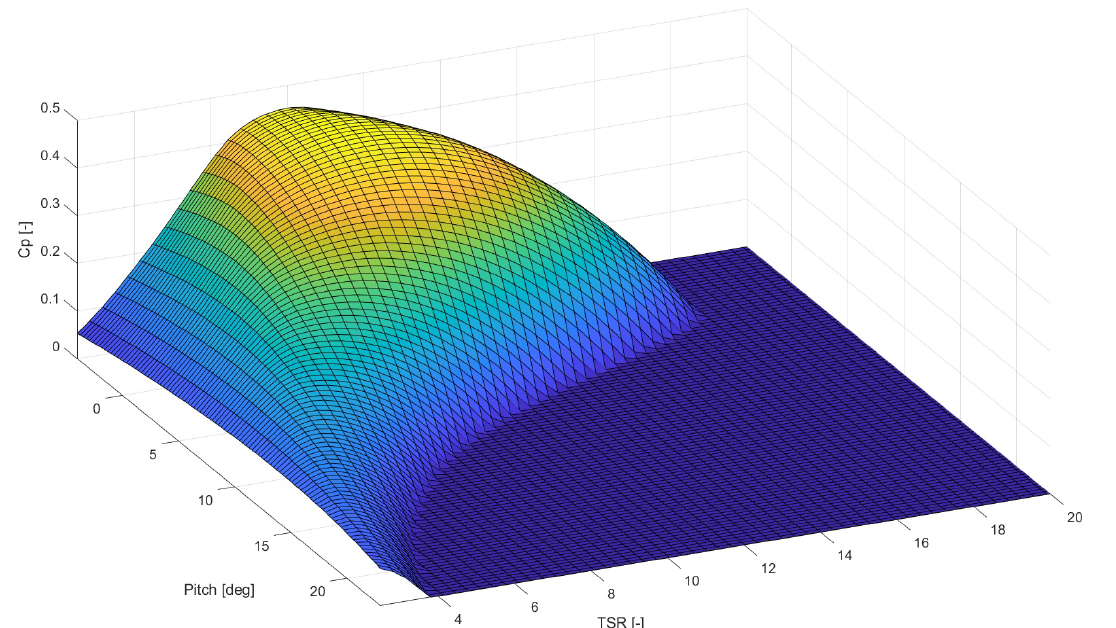
Figure A1. Calculated C p ( β,λ ) surface for the Vestas V52 turbine. For illustrative purposes, negative C p values have been replaced with zero.